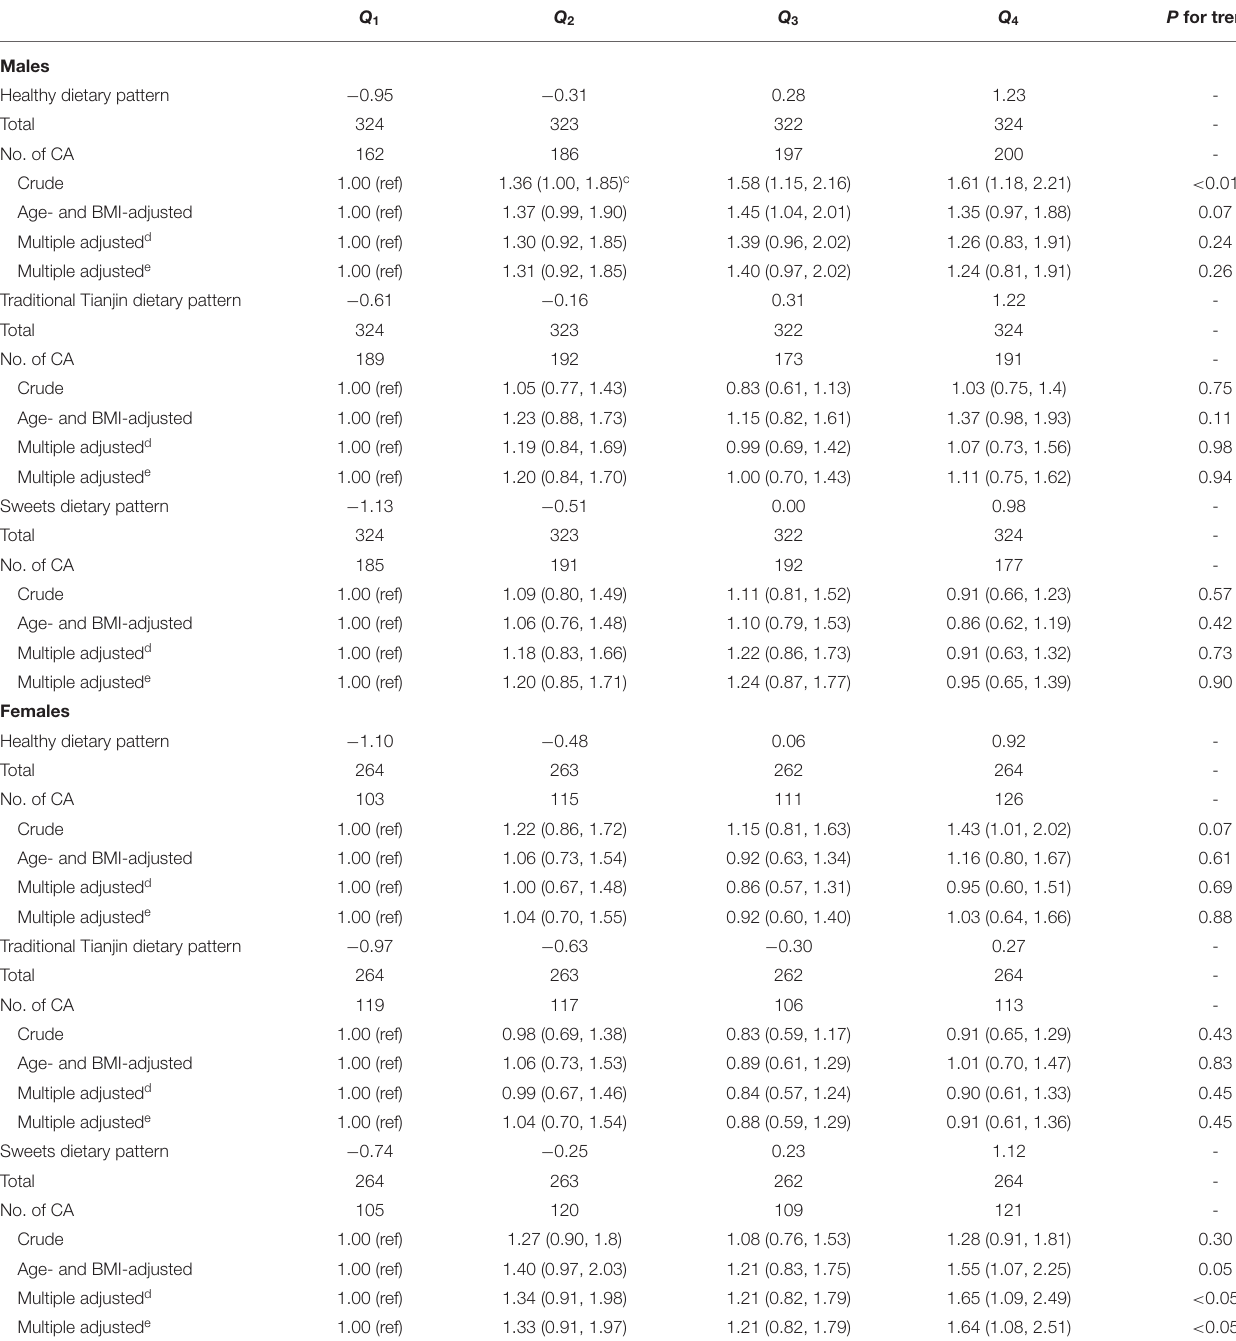
TABLE 3 | Adjusted relationships between dietary patterns to the prevalence of CA a . Q 1 Q 2 Q 3 Q 4 P for trend